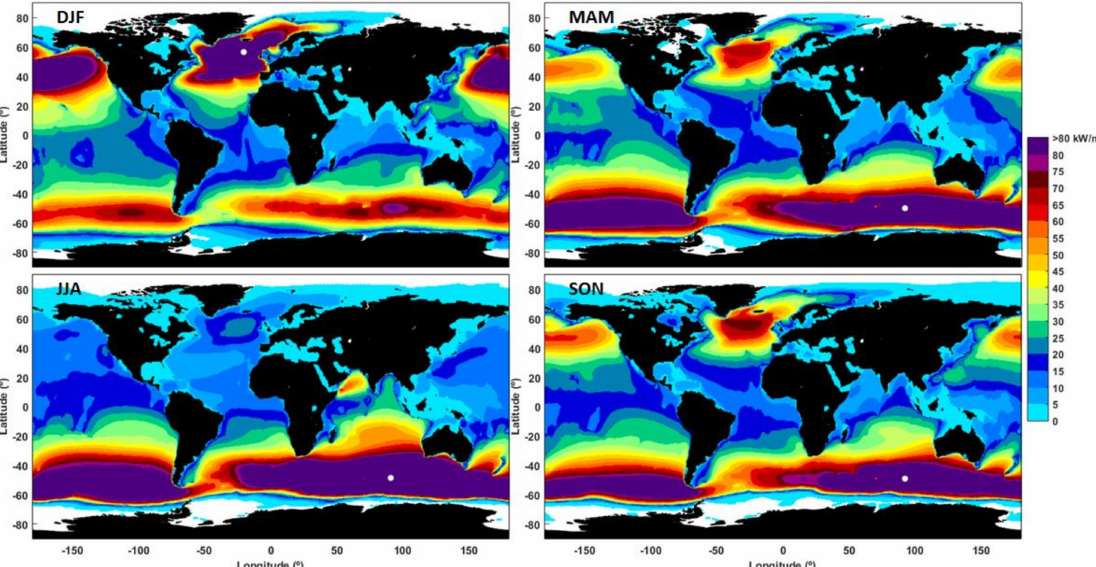
Figure 3. Seasonal variability of the mean wave power over the 30-year time interval (from 1989 to 2018) based on ERA5 data (the seasons correspond to the Northern Hemisphere): winter (DJF: December, January, February), spring (MAM; March, April, May), summer (JJA: June, July, August), autumn (SON: September, October,